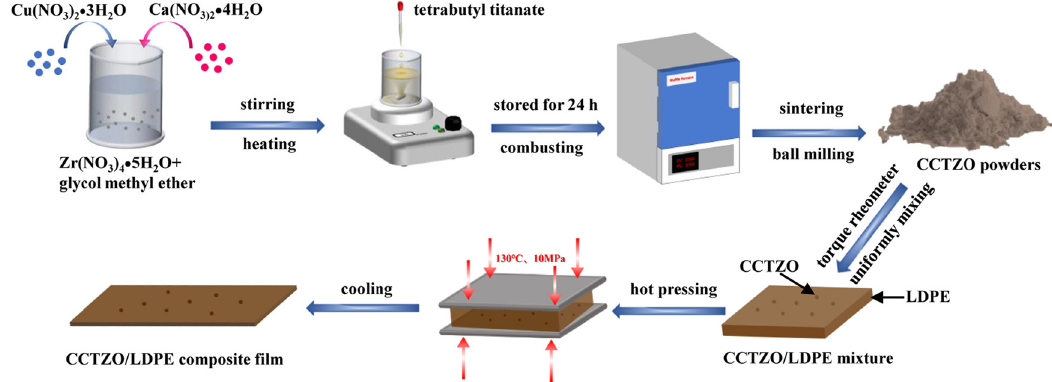
Scheme 1: Schematic diagram of the preparation of CCTO, CCTZO ceramics, and LDPE composite